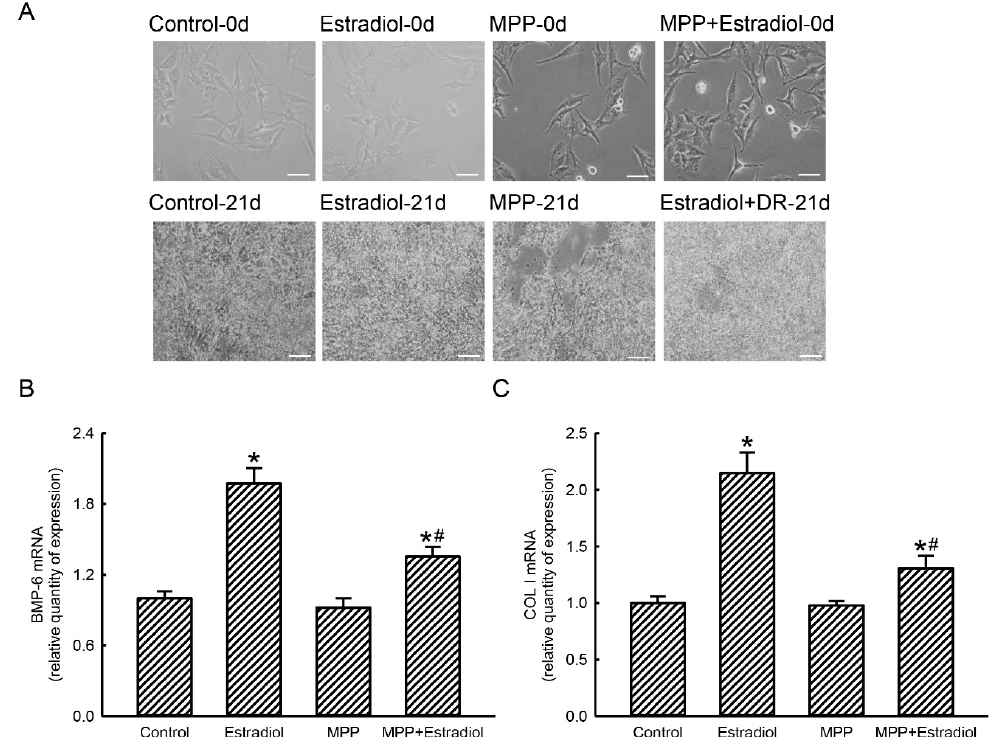
Figure 5. Methylpiperidinopyrazole (MPP) inhibited estradiol-induced expressions of osteoblast maturation-associated bone morphometric protein (BMP)-6 and type I collagen (COL I) mRNA expressions in rat calvarial osteoblasts. Primary osteoblasts isolated from neonatal rat calvarias were exposed to a di ff erentiation agent with estradiol or with a combination of MPP and estradiol for 21 days. Control cells received dimethyl sulfoxide (DMSO) or MPP only. The di ff erentiation agent, MPP, and estradiol were renewed every 2 days. Cell morphologies were observed and photographed using an inverted light microscope ( A ). After drug treatment, total RNAs were prepared from various groups using a TRIzol protocol. Levels of BMP-6 mRNA ( B ) and COL I mRNA ( C ) were analyzed using a real-time PCR. Amounts of β -actin mRNA were measured as the internal control. Each value represents the mean ± standard deviation of at least three independent determinations. The symbols * and # indicate that values significantly ( p < 0.05) di ff ered from the control and estradiol-treated groups, respectively. Scale bar: 50 µ